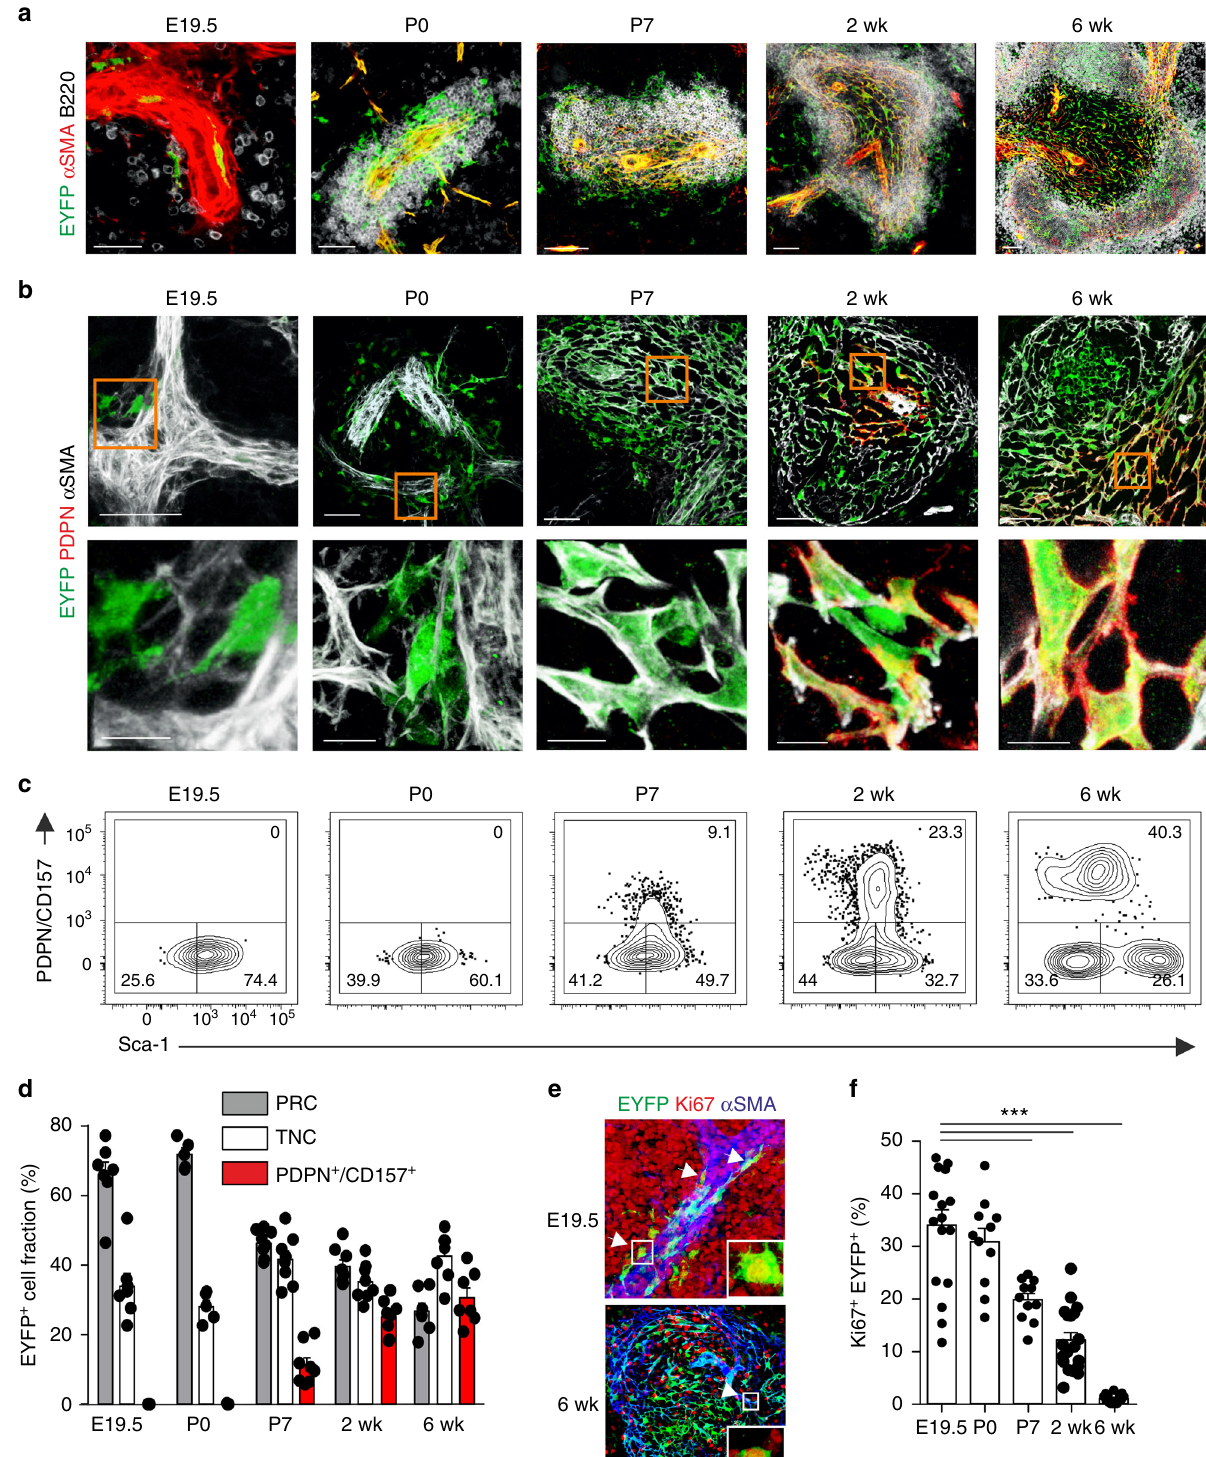
using the established cell marker pro fi les (Fig. 1g). We analyzed the transcriptome of sorted embryonic mLTo cells based on EYFP expression and adult Ltbr -de fi cient EYFP + cells to elucidate the molecular basis of postnatal mLTo cell stemness. Data ana- lysis based on differentially expressed genes revealed that the gene expression pattern of embryonic mLTo cells was distinct from adult reticular cells (Supplementary Fig. 4a). Gene set enrichment